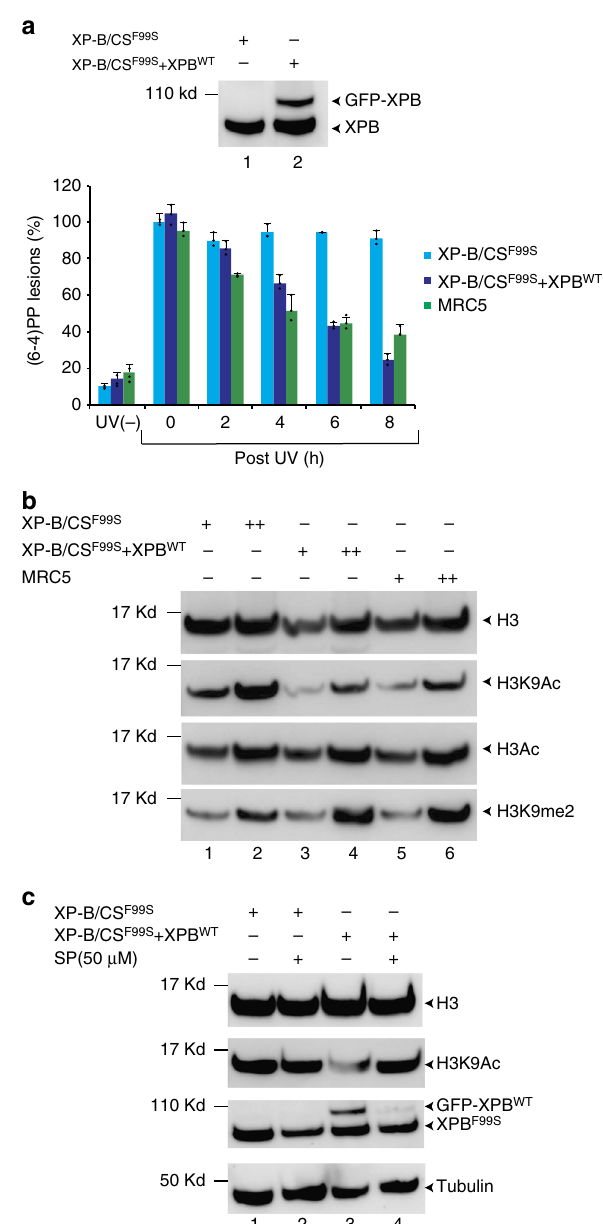
Fig. 2 XP-B/CS F99S patient-derived cells have a global increase in the H3K9ac histone mark. a Extracts from either XP-B/CS F99S or XP-B/CS F99S + XPB WT cells were resolved by SDS-PAGE and immunoblotted with a monoclonal mouse anti-XPB antibody. Source data are provided as a Source Data fi le. (6-4)PP removal measurements were carried out in XP-B/CS F99S